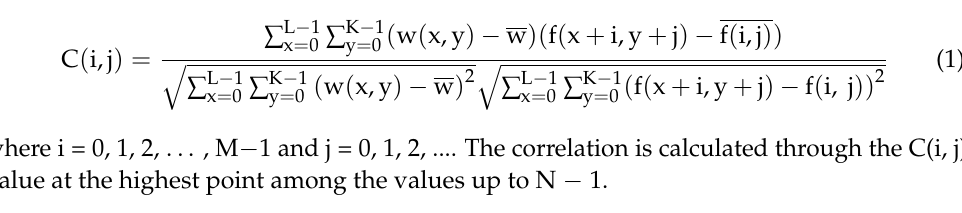
Figure 3. Conceptual diagram of cross correlation between template image and target image for calculating the pattern matching score.